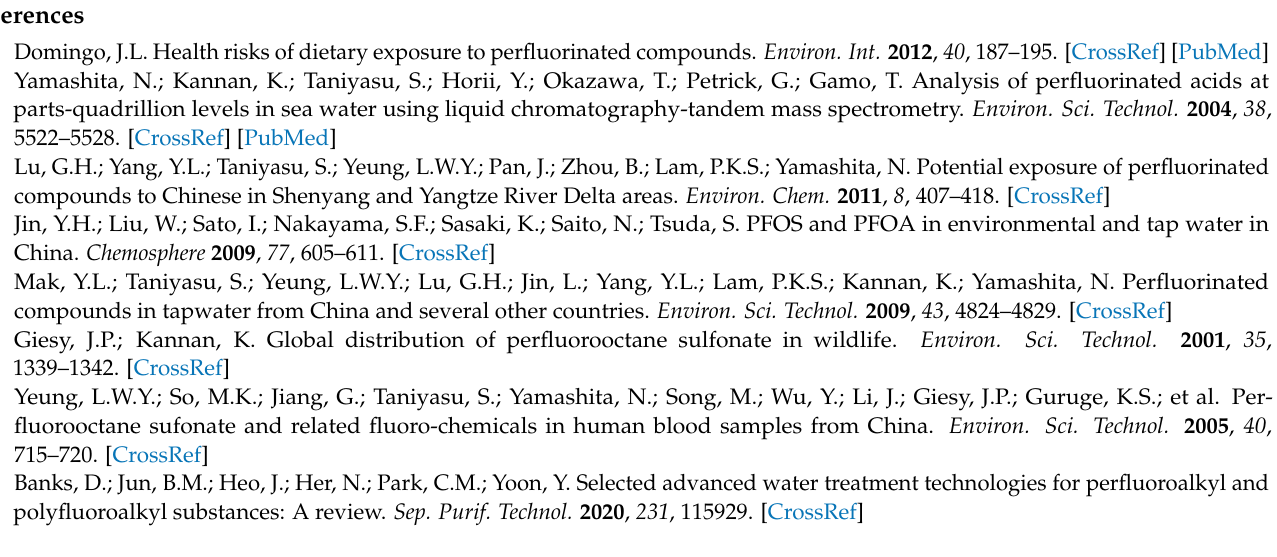
samples in Qingdao. Table S2: Information on the drinking water and groundwater samples from Qingdao. Table S3: The precursor and product ions in mass spectrometry, the limits of quantification (LOQs), recoveries, and the repeatability of the matrix spike recoveries for individual PFASs in the water samples. Table S4: Concentrations of the PFASs in the water